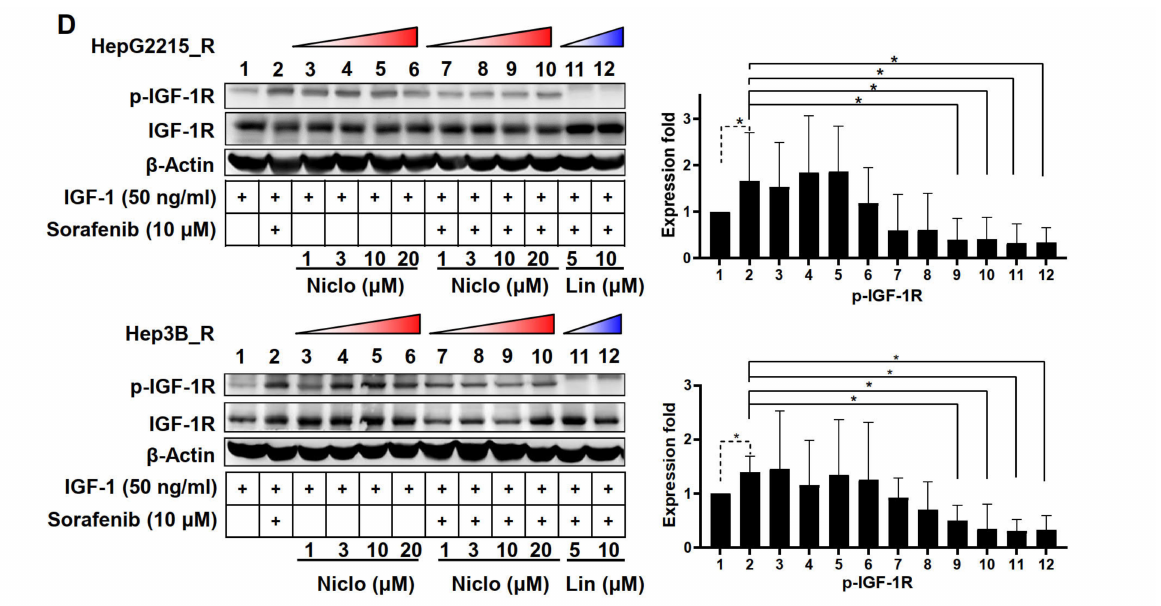
Figure 3. Niclosamide effectively mitigated IGF-1R and OCT4 expression as well as sorafenib-induced IGF-1R phosphorylation in the sorafenib-resistant HCC cells under IGF-1 treatment. ( A ) Effect of niclosamide (Niclo, 1, 3, 10, and 20 µ M) or linsitinib (L, 5, 10, and 20 µ M) on the expression of IGF-1R and stemness-related protein OCT4 in the sorafenib-resistant HCC cells. The results of three replicates were shown in Figure S9. ( B ) Cell viability assays (WST) of sorafenib-resistant HCC cells treated with niclosamide (1, 3, 5, 10, 15, 20, 30, and 40 µ M) with or without sorafenib (0.5, 2.5, 5, 10, and 15 µ M) for 24 h. The detailed data was shown in Table S3. ( C ) Cell viability assays (WST) of sorafenib-resistant HCC treated with linsitinib (1, 2, 5, and 10 µ M) with or without sorafenib (1, 2.5, 5, and 10 µ M) for 24 h. CI values were interpreted as follows: CI > 1, antagonistic effect; CI = 1, additive effect; and CI < 1, synergistic effect. The detailed data was shown in Table S3. ( D ) Effect of niclosamide (Niclo, 1, 3, 10, and 20 µ M) or linsitinib (Lin, 5, 10, and 20 µ M) on IGF-1/sorafenib-induced IGF-1R phosphorylation of the sorafenib-resistant HCC cells. The results of three replicates were shown in Figure S11. * p < 0.05 as obtained from one-way